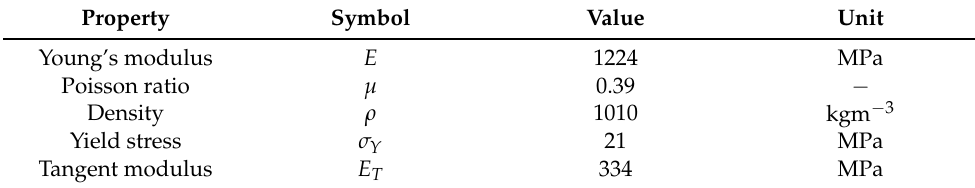
Table 1. Mechanical properties of PA12.